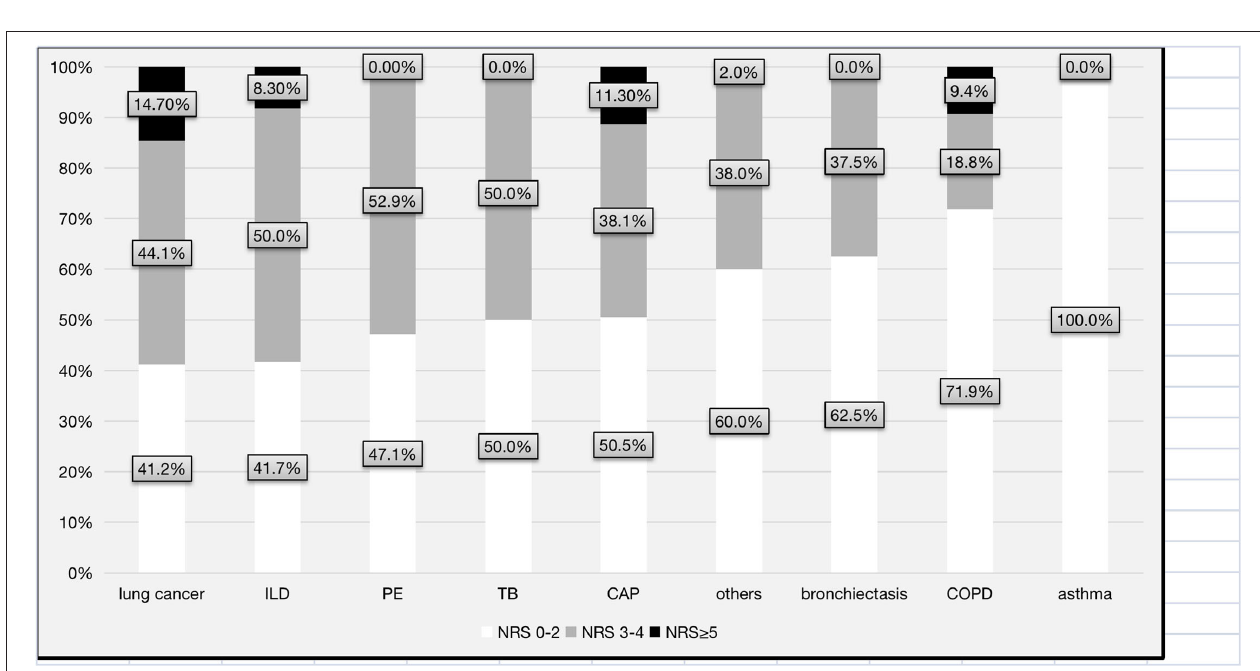
(30), potentially explaining the more consistent and stronger association of ILD severity with unfavorable body composition and low physical function for men than for women. Furthermore, DHEA has antifibrotic effects on human fibroblasts in vitro